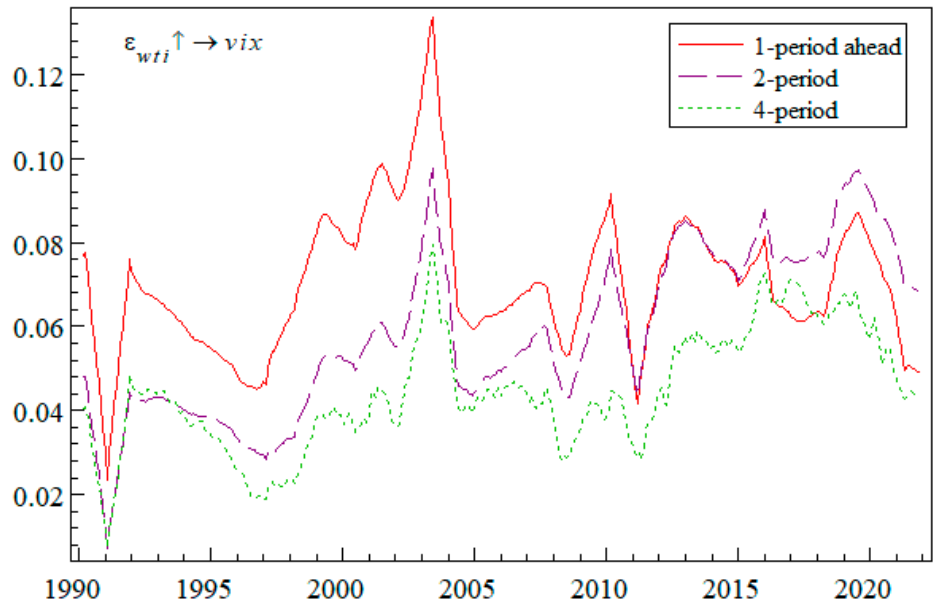
Figure 3. Impulse response of VIX index to international crude oil price in different periods.